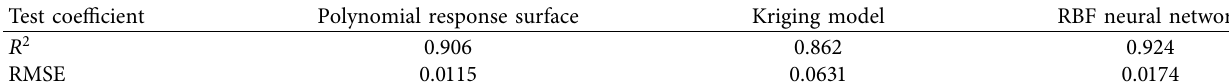
Figure 27: Approximate model of the process of vehicle crossing trench. (a) Polynomial response surface. (b) Kriging model. (c) RBF neural network. Table 16: Accuracy test of approximate model of vehicle crossing trench.